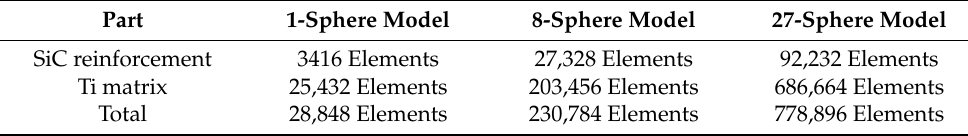
Figure 5. The middle sections of ( a ) 1-sphere, ( b ) 8-sphere, and ( c ) 27-sphere models. Table 6. Characteristics of different meso-scale model arrangements.